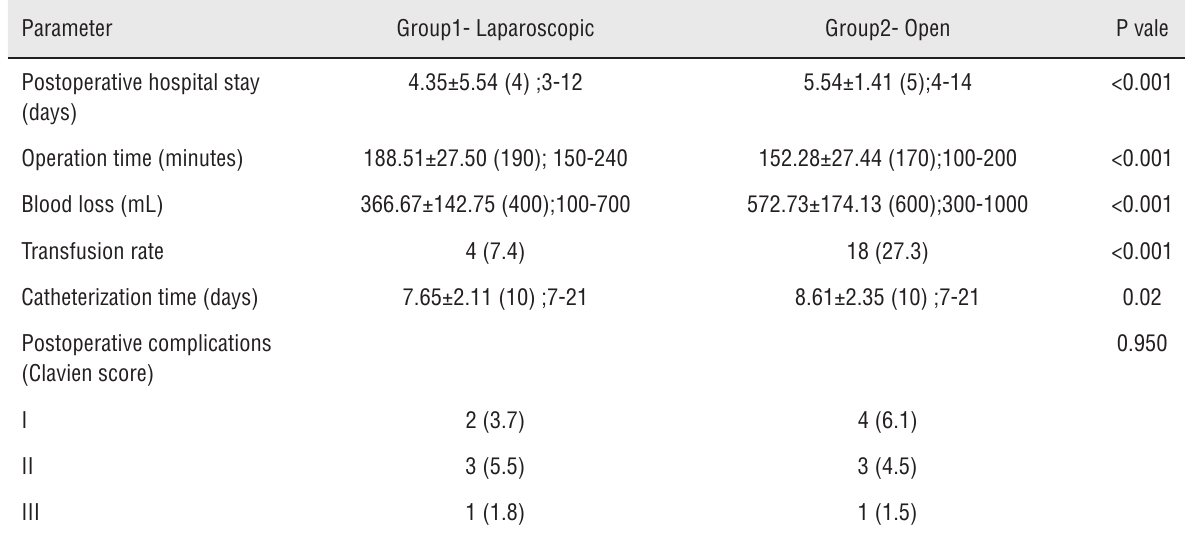
Table 2 - Comparison of perioperative outcomes between laparoscopic and open procedures. Results are presented as mean ± sD (mean) and range or number (%) of cases.